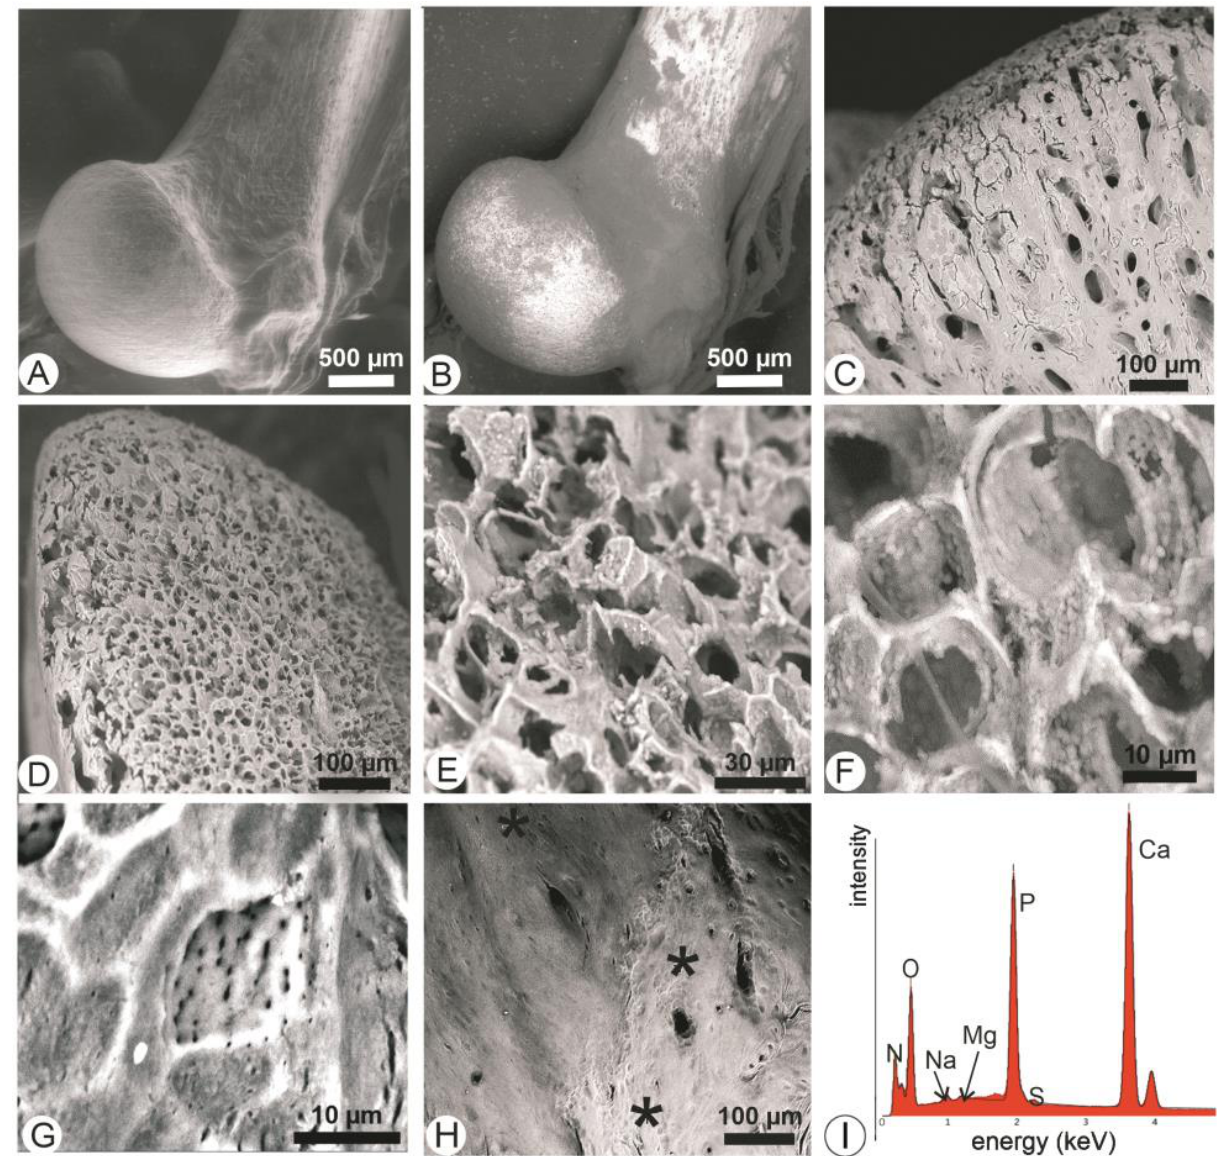
Figure 4. Trypsin hydrolyses (5 mg/mL). ( A , B ). Humeral epiphysis of Mus ; A: SE image, B: BSE image. ( C – F ). Porosity of the condyle and epiphysis of a tibia ( Apodemus ). ( G ). Haversian system and wavy zones and cupules due to the bone resorption femur ( Apodemus ). ( H ) Localization of electron microprobe spectra: stars ( I ). Spectra show that P and Ca are present as well as Na, Mg and S.